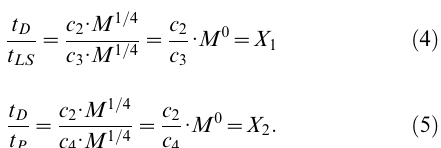
* PRV: Pseudorabies Virus, TSE: Transmissible Spongiform Encephalopathy, WNV: West Nile Virus Significant p values ( , 0.05) denote slopes that differ from 0. Bolded slope values do not differ from 0.25. Slope and intercept values that differ among diseases (but within each time category) have different super-scripted letters. The intercept value for t S is c 1 and for t D is c 2 (Eqns 1, 2).